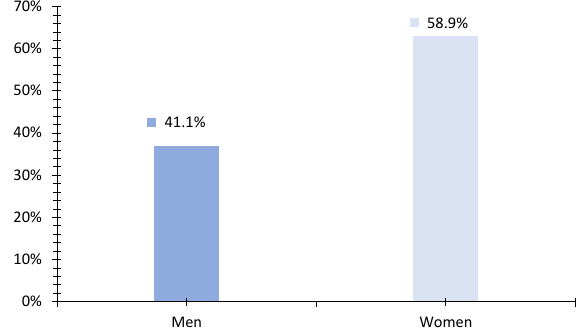
Figure 1. Sex distribution of participants for the